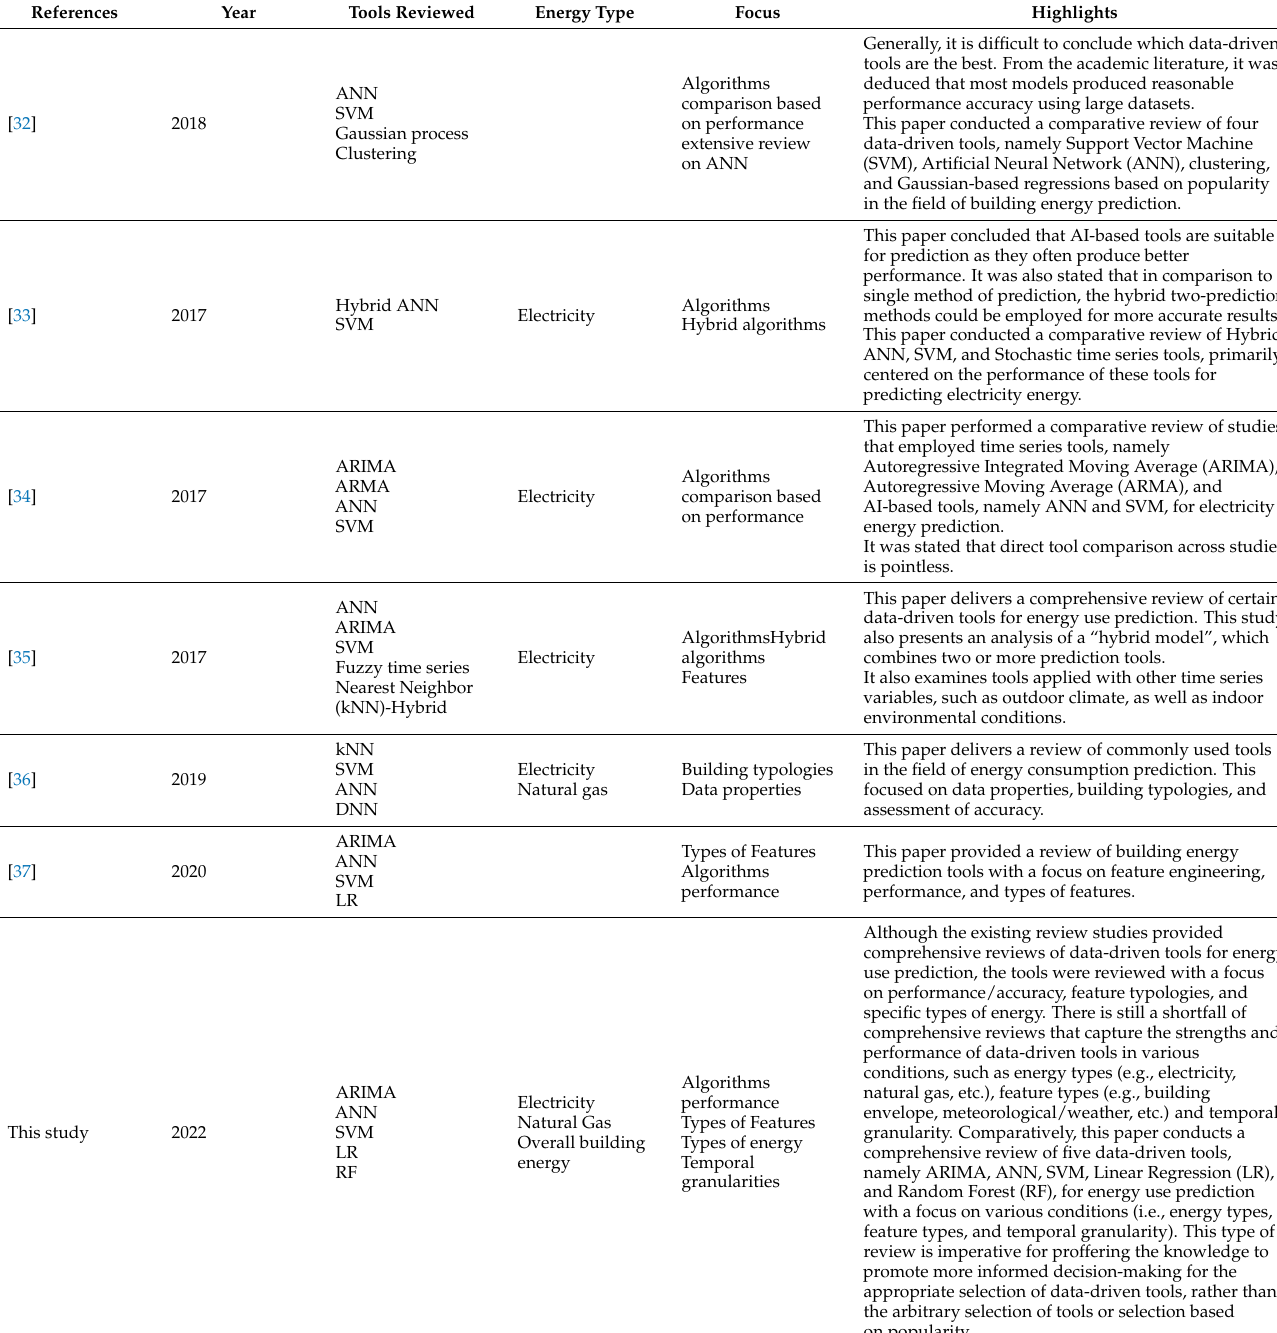
Table 1. Overview of existing review studies and this